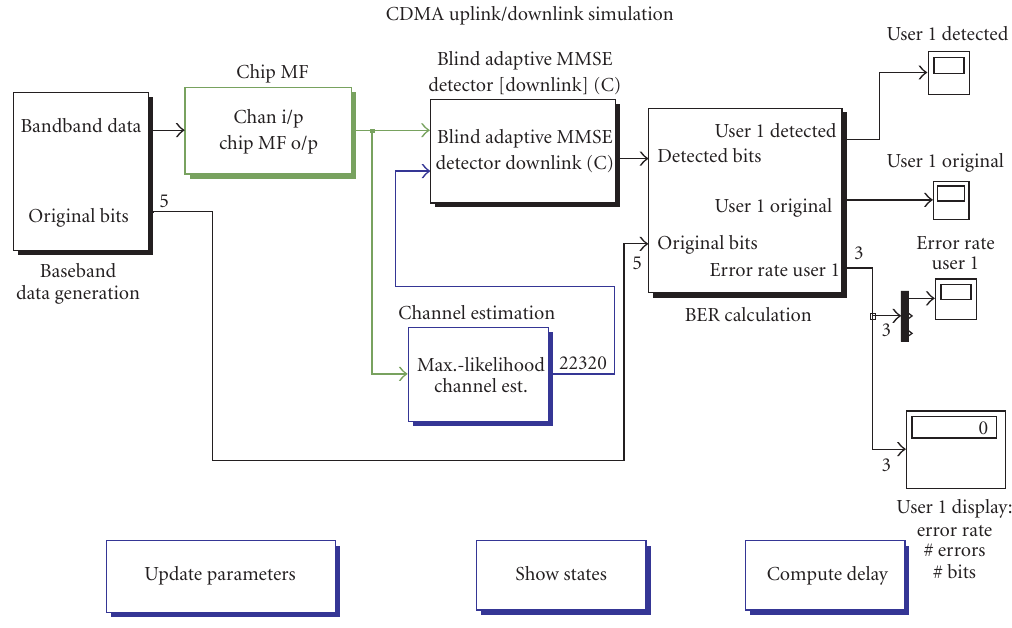
Figure 11: The RENE CDMA testbed, which performs CDMA uplink and downlink simulations.